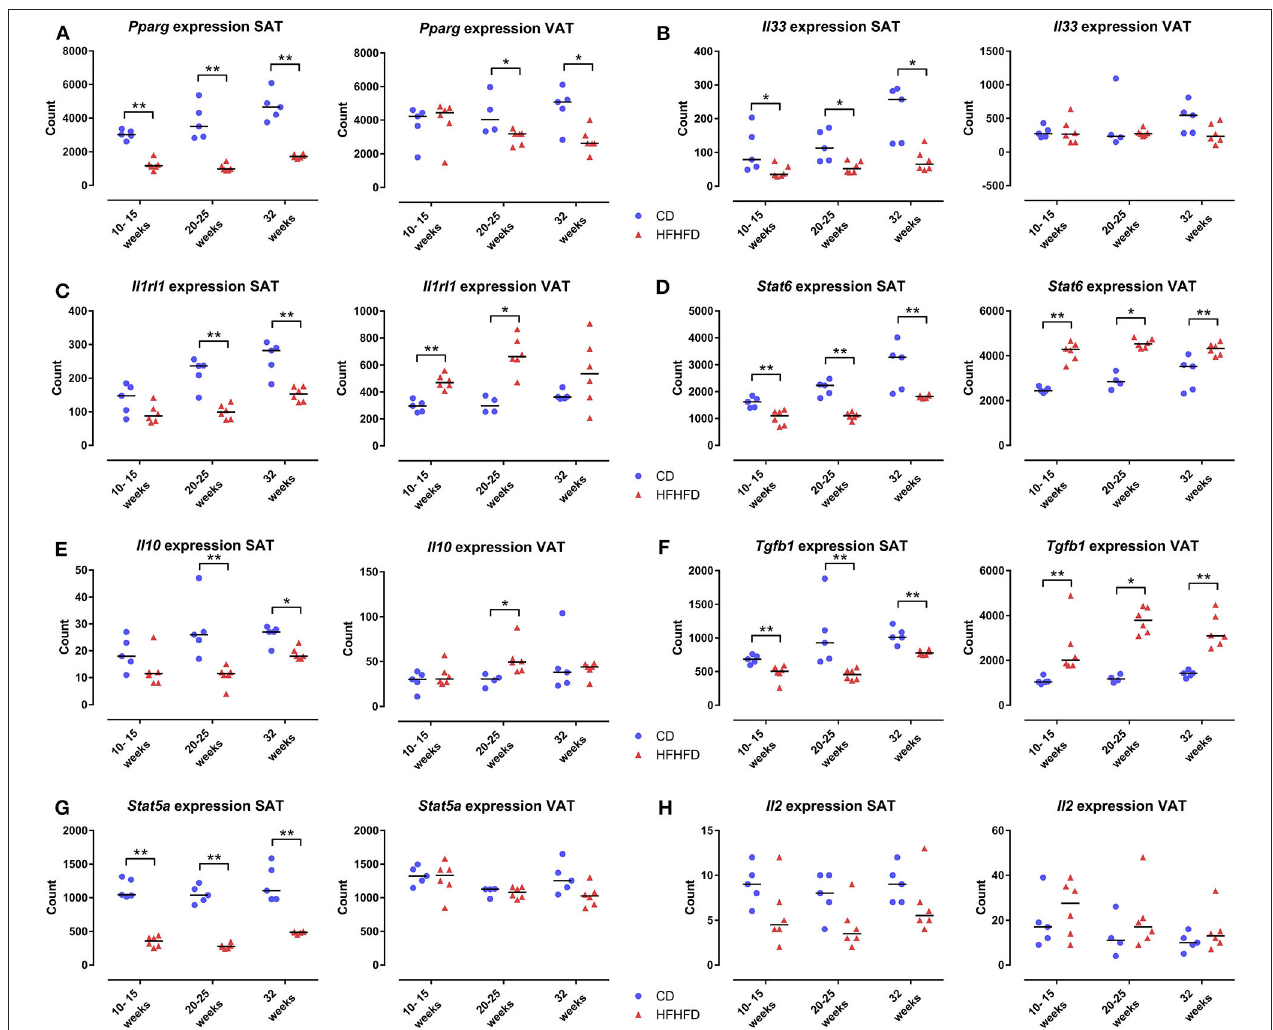
FIGURE 5 | Gene expression in SAT and VAT comparing CD-fed and HFHFD-fed mice at an experimental duration of 10–15, 20–25, and 32 weeks. (A) Pparg . (B) Il33 . (C) Il1rl1 , coding for the protein ST2. (D) Stat6 . (E) Il10 . (F) Tgfb1 . (G) Stat5a . (H) Il2 . Gene expression is expressed in normalized counts. Medians are depicted with a horizontal black line. * P < 0.05; ** P < 0.01 (Mann Whitney U). CD, control diet; HFHFD, high-fat high-fructose diet; SAT, subcutaneous adipose tissue; VAT, visceral adipose